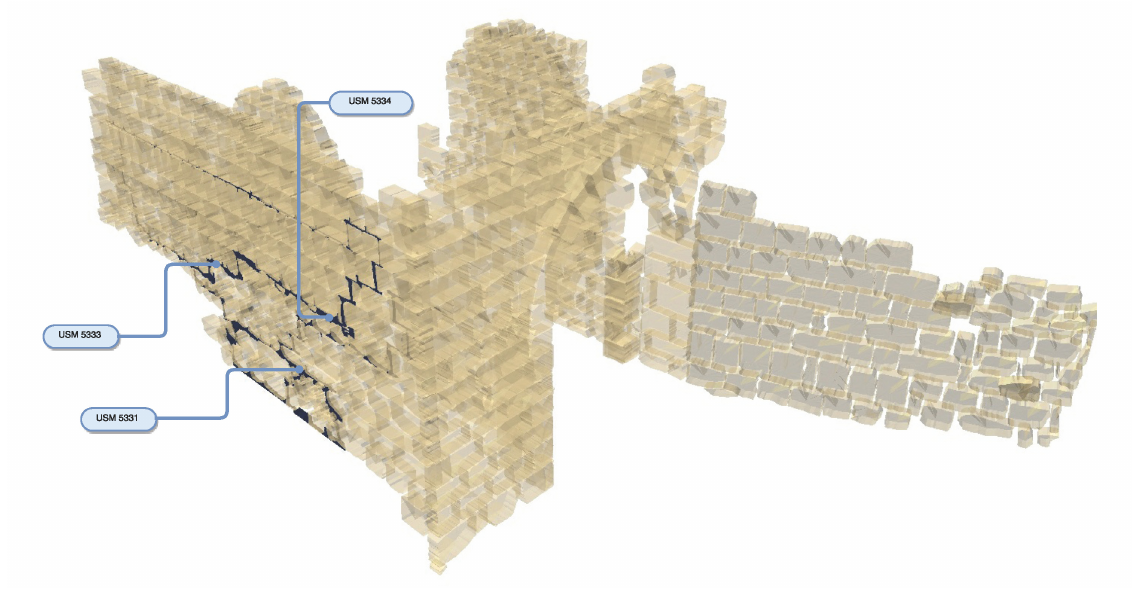
Figure 16. Negative USM represented by the set of 3D points extracted using the perimeters designed on the photographs by an